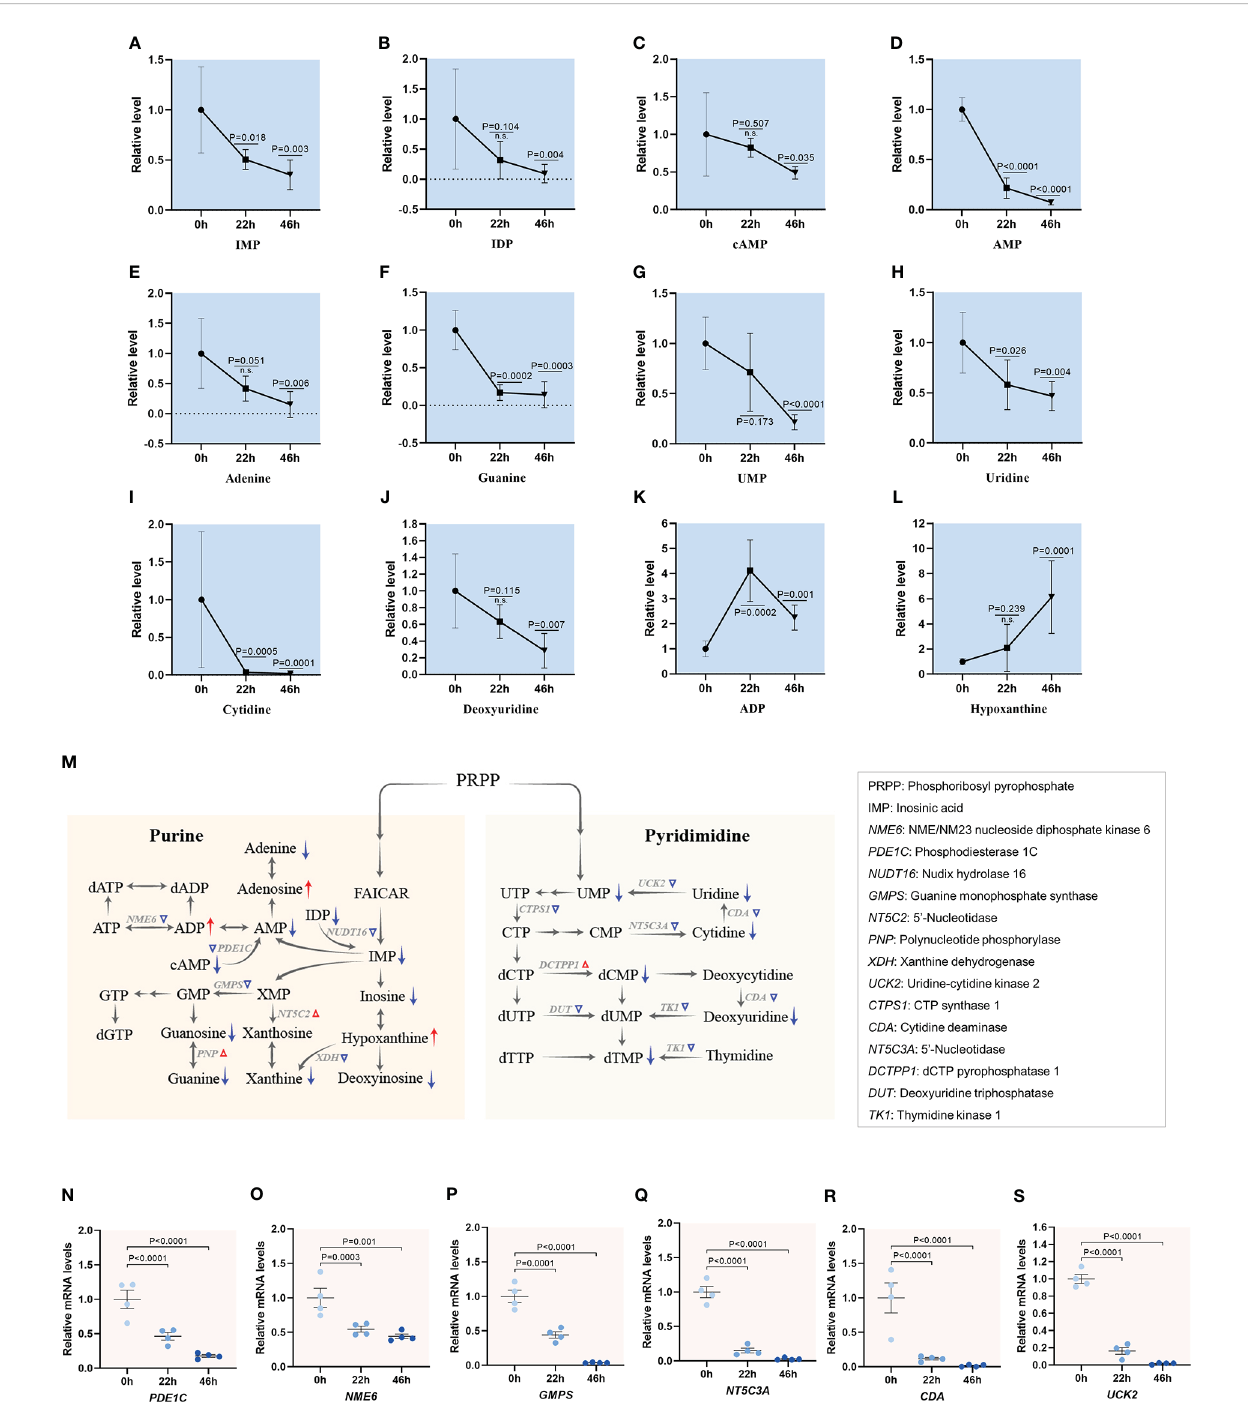
FIGURE 8 Metabolic changes in nucleotides during oocyte maturation. (A-L) Relative levels of metabolites related to nucleotide metabolism in oocytes at three time points. (M) Schematic diagram of nucleotide metabolism during meiotic maturation, derived from metabolomics and transcriptomics. The red and blue arrows denote the metabolites that are upregulated and downregulated, respectively. DEGs increased and decreased are indicated by red and blue triangles, respectively. (N – S) Relative levels of DEGs involved in glucose metabolism during oocyte maturation. Error bars, SD. Student ’ s t test was used for statistical analysis in all panels, comparing to GV. n.s., not signi fi